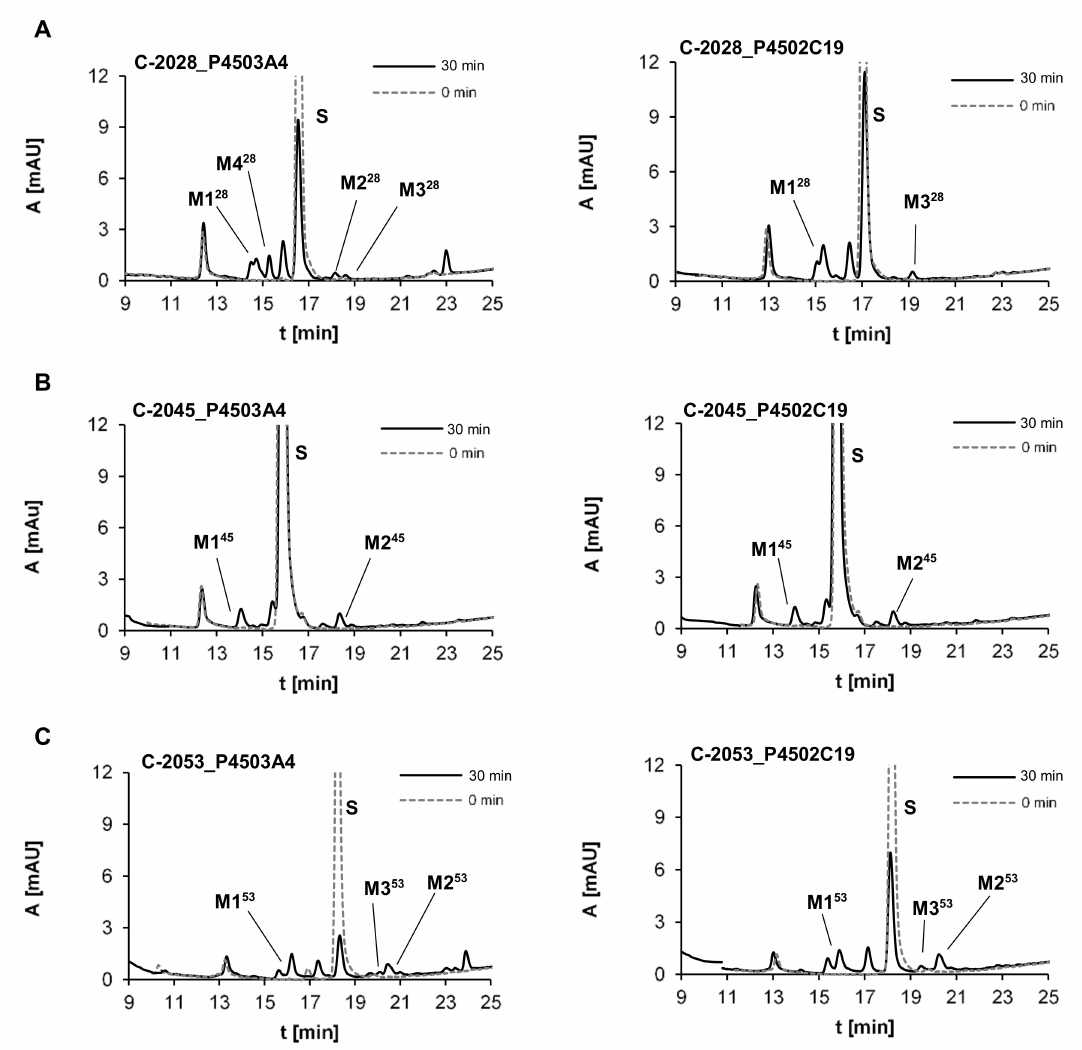
Figure 4. HPLC analysis of the reaction mixture after 30 min incubations of 0.05 mM ( A ) C-2028, ( B ) C-2045 and ( C ) C-2053 with 1 mg/mL of cytochromes P4503A4 and P4502C19. The 2 mM NADPH was applied as the